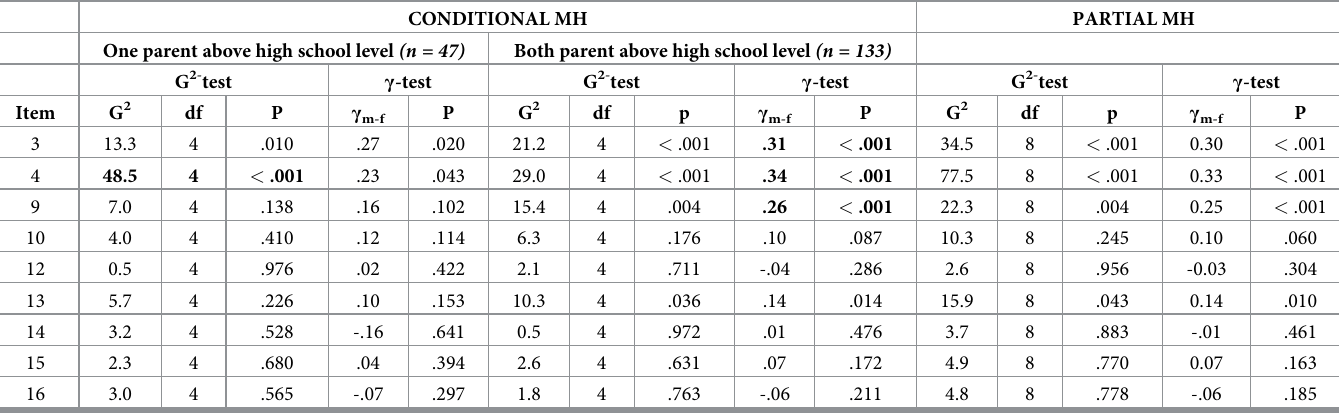
Table 5. Test for marginal homogeneity between mothers’ and fathers’ responses across parent couple educational status. CONDITIONAL MH PARTIAL MH